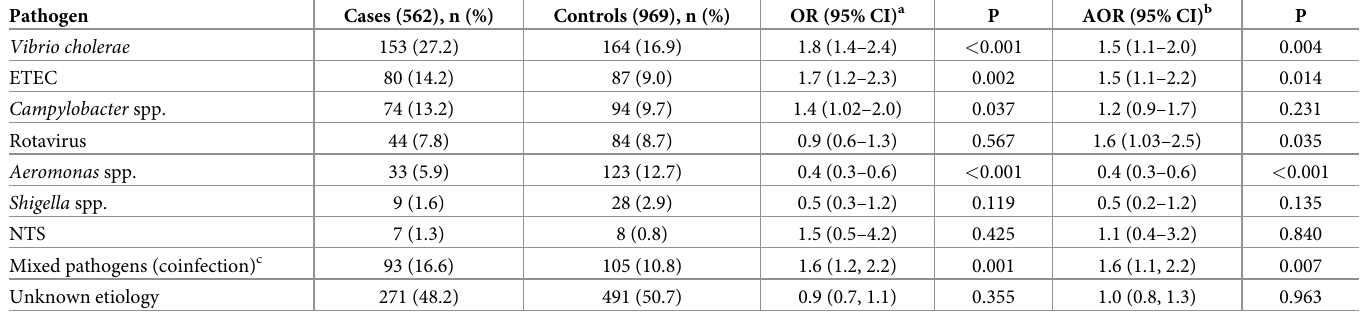
Table 2. Distribution of enteric pathogens isolated from DDSS-enrolled patients treated at icddr,b Dhaka Hospital during the epidemic (cases) and the comparison period (controls) and odds ratio of diarrhea during the epidemic (compared to the comparison period) for high-priority pathogens.